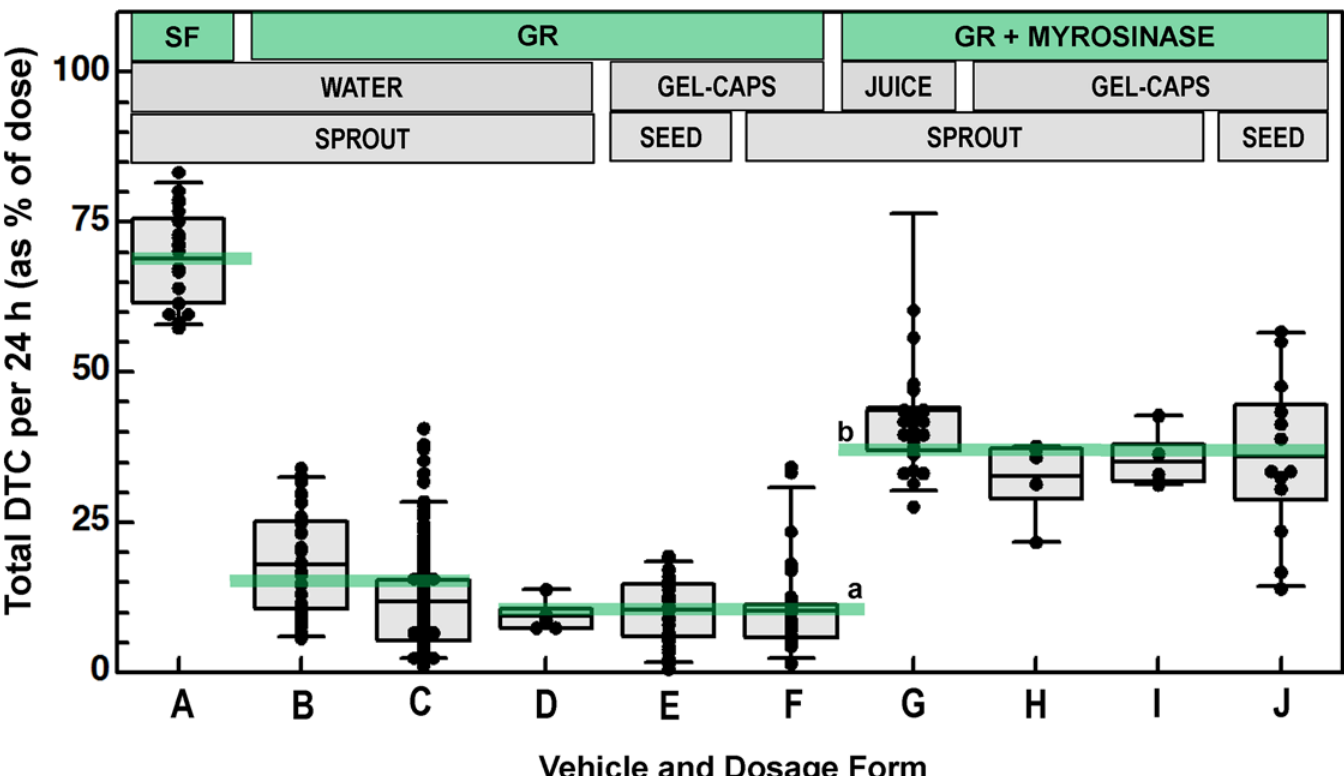
Fig 1. Mean daily excretion / conversion of SF- or GR-rich broccoli preparations to SF metabolites. Preparations are: SF-, GR-, or GR plus Myrosinase-rich; they are delivered either in water, juice, or gel-caps; and they are derived from either sprouts or seeds, as indicated at top of graph. Boxes around data points delineate the 25 th to 75 th percentile of values, and whiskers delineate the 5 th and 95 th percentiles. Solid line through middle of box is the mean. “ Cohort numbers ” in the following are from Table 1 : (A) Hospitalized subjects given SF-rich BSE (mean 68.9%, data from Ref. [19]); (B) Hospitalized subjects given GR-rich BSE (mean 18.0%, data from Ref. [19]); (C) Free-living subjects given GR-rich BSE (mean 11.8%, data from Ref. [7]); (D) Cohort 1 (BSE in water; mean 9.4%); (E) Cohort 3 (Xymogen BSdE in gel-caps; mean 10.4%); (F) Cohort 2 (JHU BSE in gel-caps; mean 10.3%); (G) Cohort 6 (FDBS in dilute pineapple-lime juice; mean 44%); (H) Cohort 5 (FDBS in acid-resistant gel-caps; mean 32.7%); ( I) Cohort 5 (FDBS in regular gel-caps; mean 35.1%); (J) Cohort 4 (BSdP; 35.9%). There is a highly significant difference between the means of D through F a (10.3%), and G through J b (39.6%), (p = 0.0000, by oneway